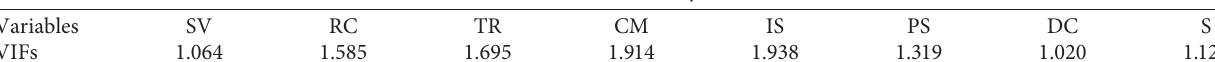
Table 8: Full collinearity